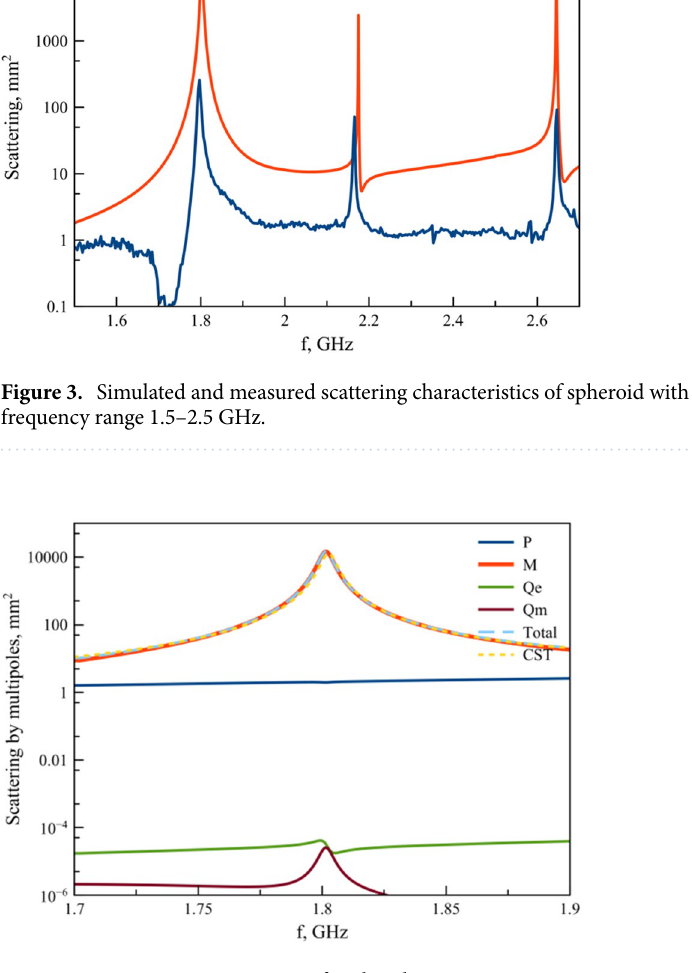
Figure 4. Scattering cross section of multipoles on 1.8